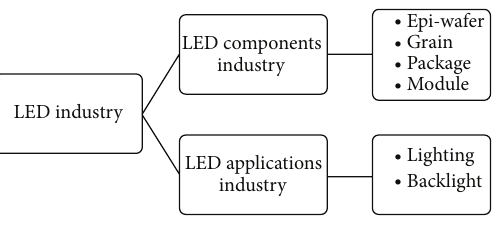
Figure 1: Scope of the LED industry. Source: this